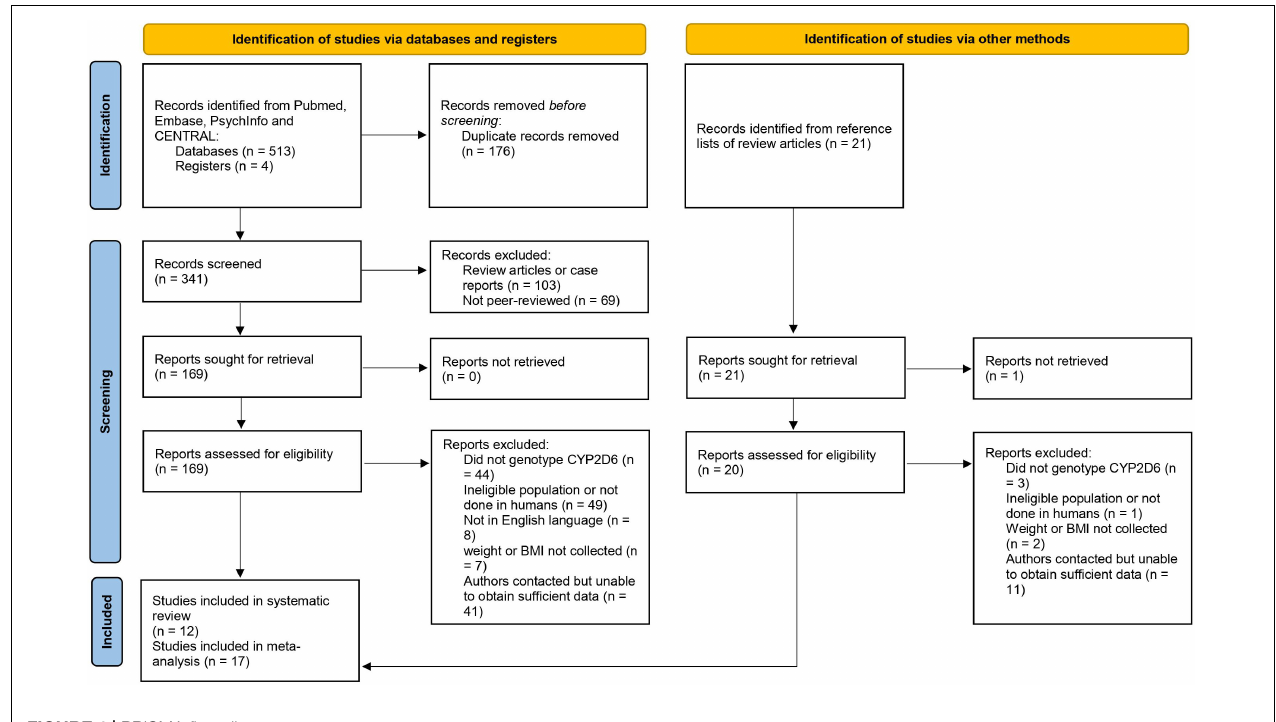
FIGURE 1 | PRISMA flow diagram. TABLE 1 | The characteristics of the cohort observational studies included in the systematic